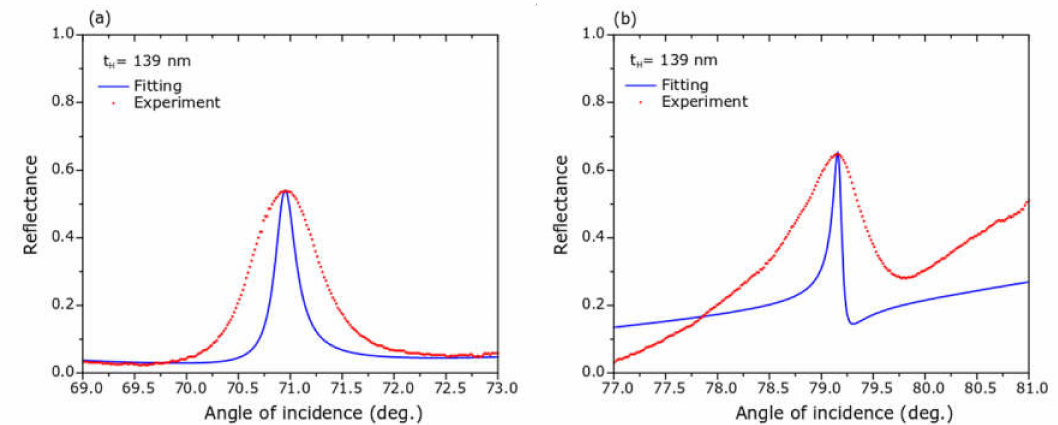
Figure 7. Partial sections of experimental and fitted ATR spectra shown in Figure 6c for water ( a ) and dried egg white ( b ). Data in these figures is the same as that in Figure 6c, except that the experimental data was multiplied by a constant factor. The purpose is the comparison of the angular position of theoretical and experimental reflectance peaks.